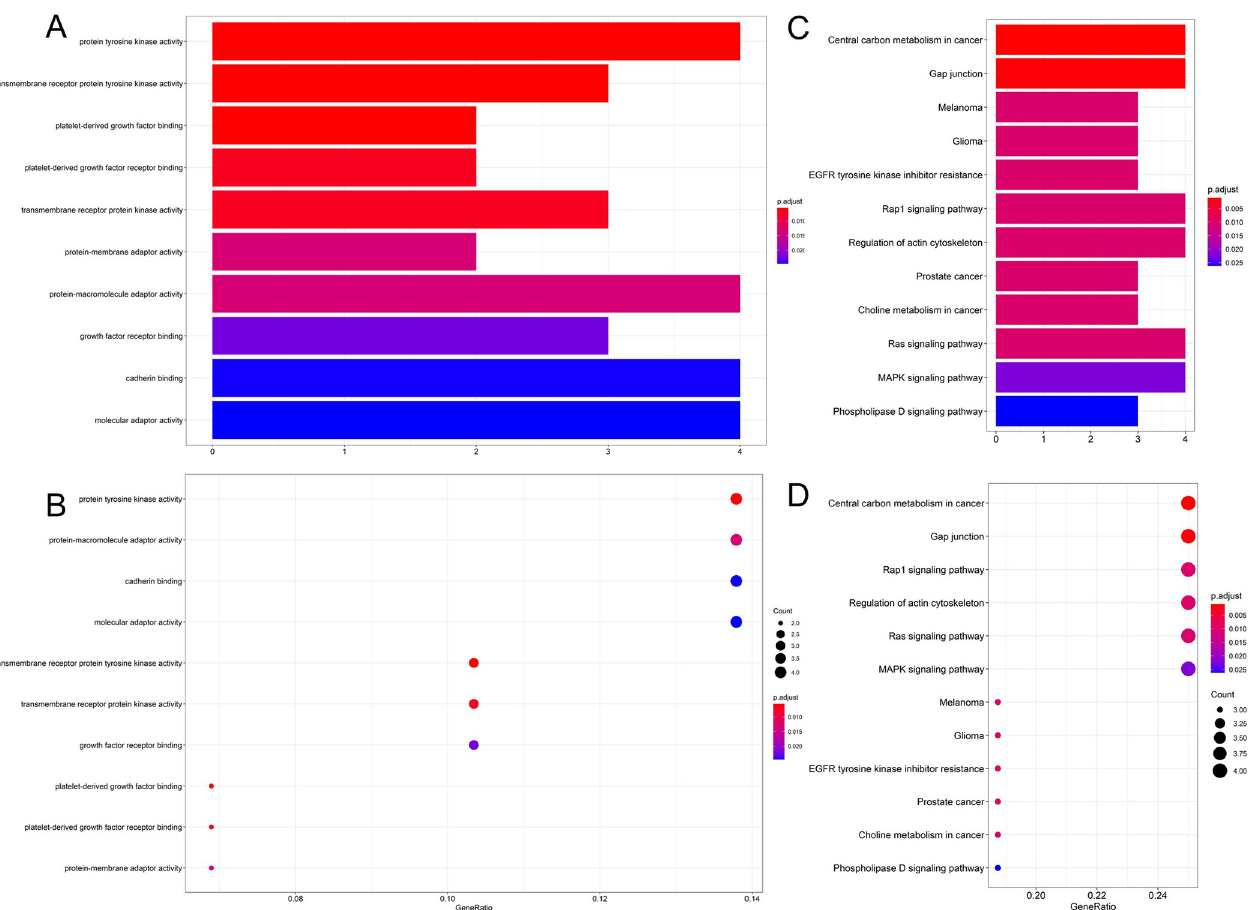
Fig 5. GO and KEGG enrichment analysis. A and B, GO enrichment analysis; C and D, KEGG enrichment analysis.